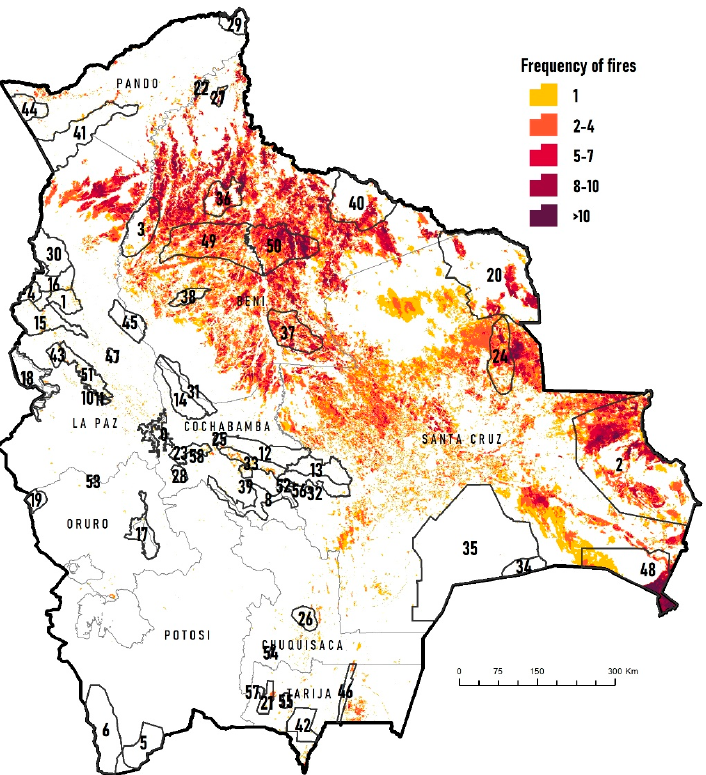
Figure 7. Frequency of wildfires in the KBA of Bolivia, in the period 2001–2020 based on the MCD64A1 product.